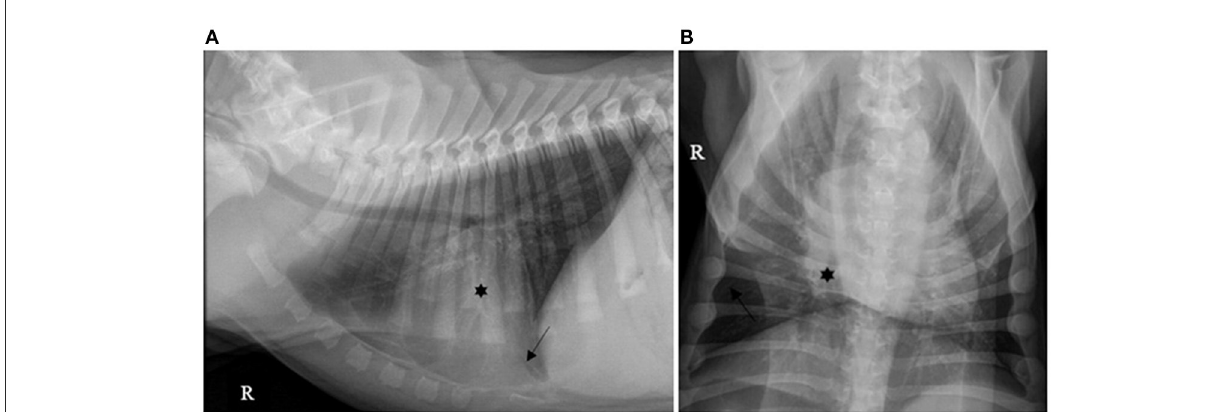
FIGURE1 (A) Right lateral and (B) ventro-dorsal thoracic X-rays of a dog with AP associated with a small amount of PE. A discrete alveolar pattern is visible in the right middle lobe (*). A discrete PE is identified by identification of thin fissure lines between the lobes (dark arrows). AP, aspiration pneumonia; PE, pleural effusion (source: medical imaging department of the veterinary university clinic of Liege, Belgium).